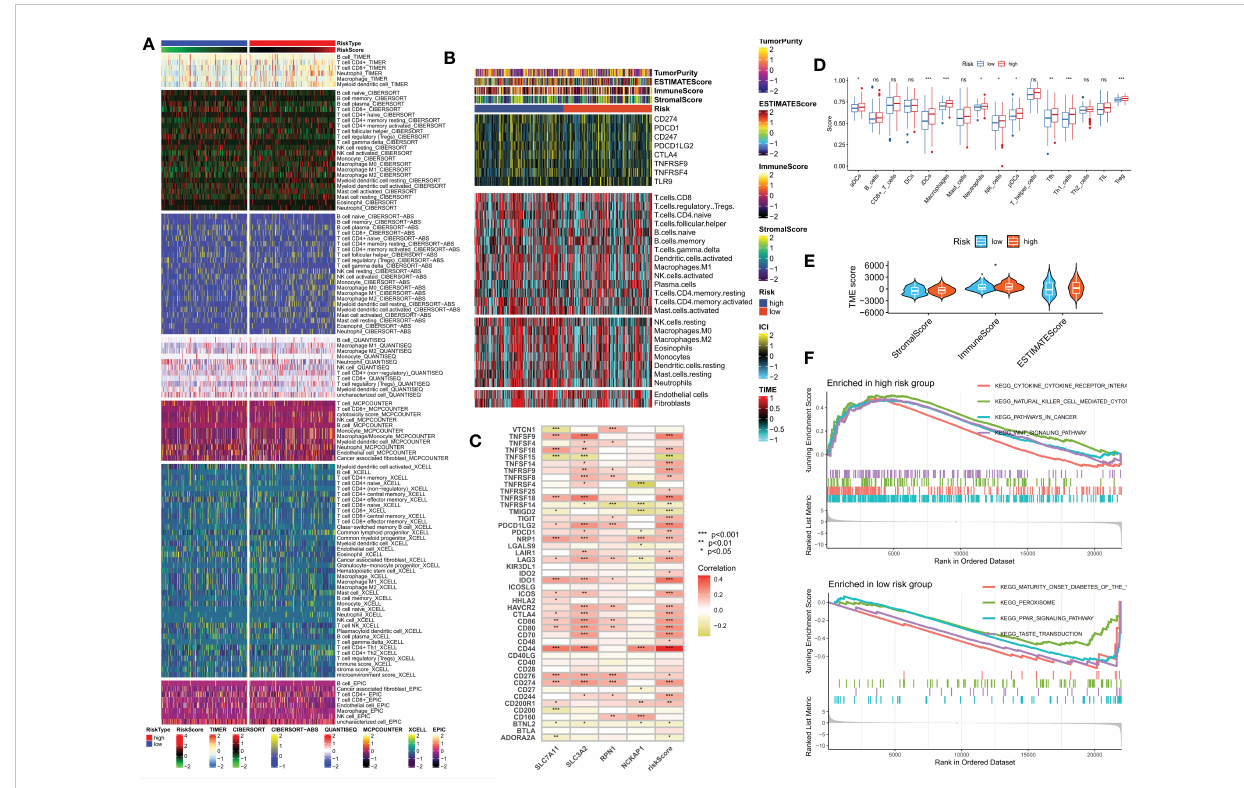
FIGURE 8 Analysis of the immune microenvironment in different risk groups. (A) Differences in immune in fi ltration status between different risk groups were evaluated by seven algorithms. (B) Heatmap showing differences in TME score, immune checkpoint expression, and immune cell in fi ltration calculated by Cibersort among different risk subgroups. (C) Correlation between the expression of all immune checkpoints and DRG and risk scores. (D) Differences in immune cell in fi ltration between different risk groups. (E) Differences in TME scores between different risk groups. (F) GSEA analysis of different KEGG pathways focused on high and low-risk groups. ns, no signi fi cance, *p< 0.05, **p< 0.01, ***p<